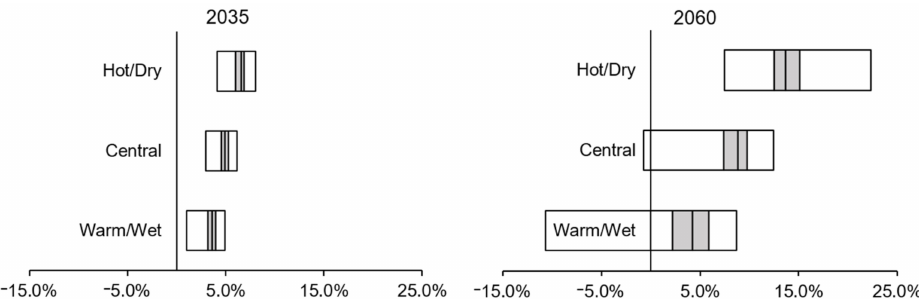
Figure 5. Box-and-whisker plots of projected changes in annual water system energy